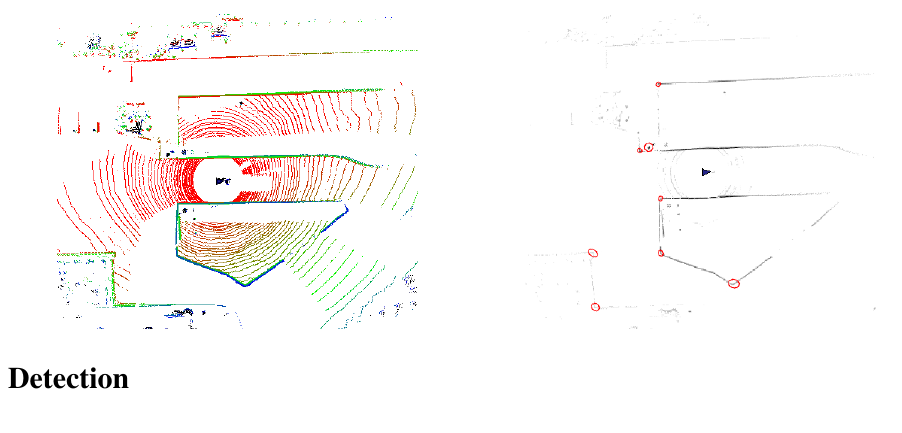
Figure 5. 3D Scan Rasterization. Left: a Velodyne scan with points colored according to Z height. Right: Rasterized image with superimposed extracted features and corresponding uncertainties. 3D LIDAR data was rasterized by considering the range of Z values in each cell of a polar